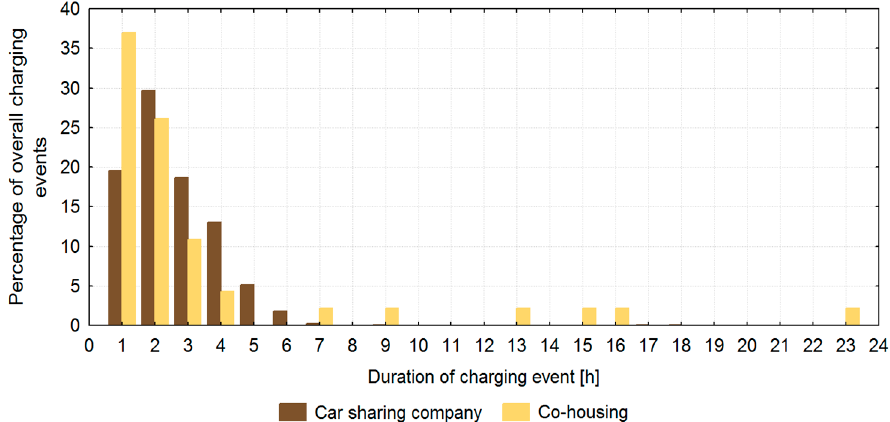
Figure 6. Charging behavior—the duration of the charging event in hours.